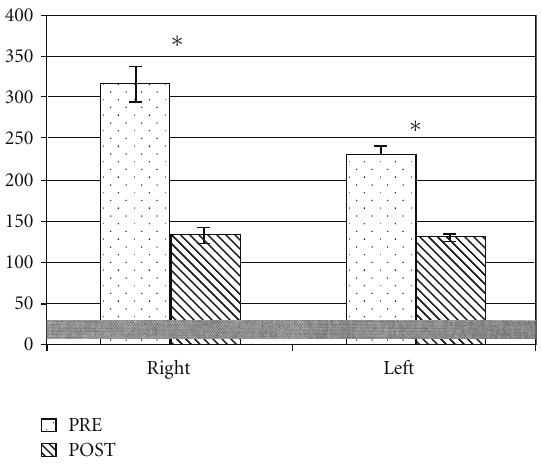
Figure 2: Comparison of GGI index (mean and standard deviation) for the subject (right and left side mean values with standard deviation) in the PRE and POST sessions; in grey the normative range is represented. ∗ P < . 05, PRE versus